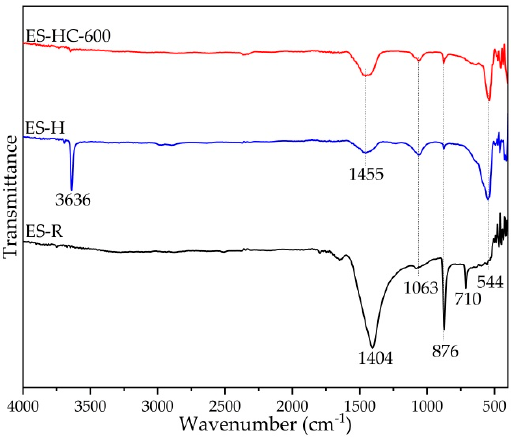
Figure 3. FT-IR spectra of ES-R, ES-H, and